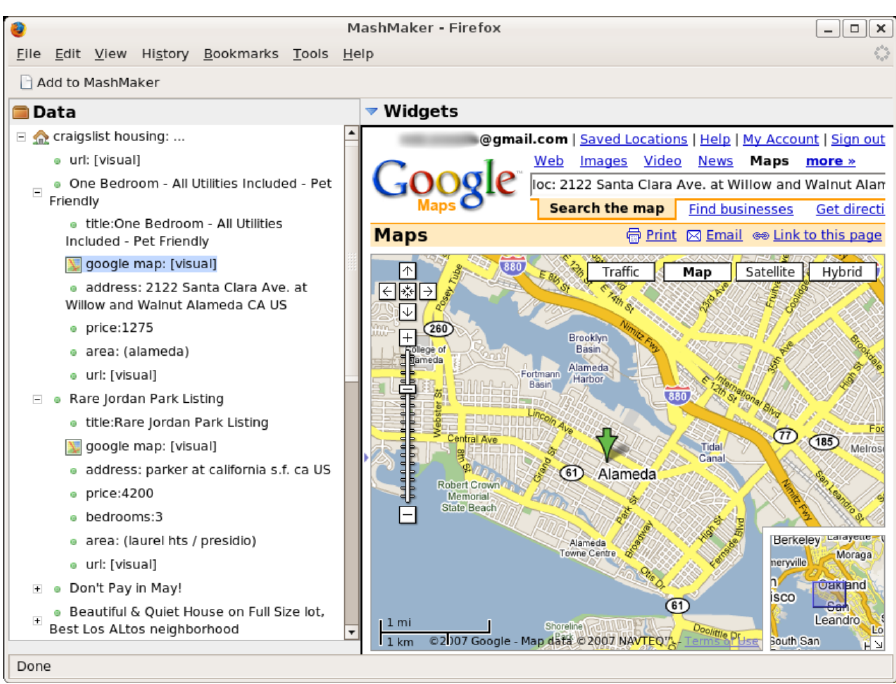
Figure 9. MashMaker example (using Google